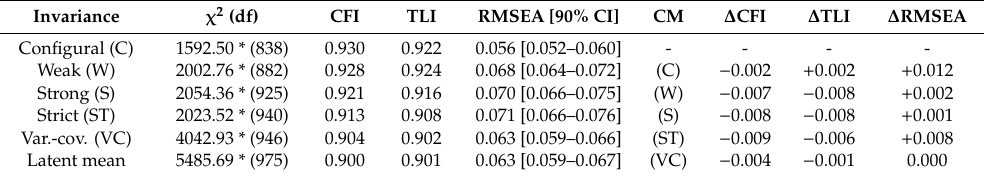
Table 4. Measurement Invariance across Gender for the six-factor CFA Model.